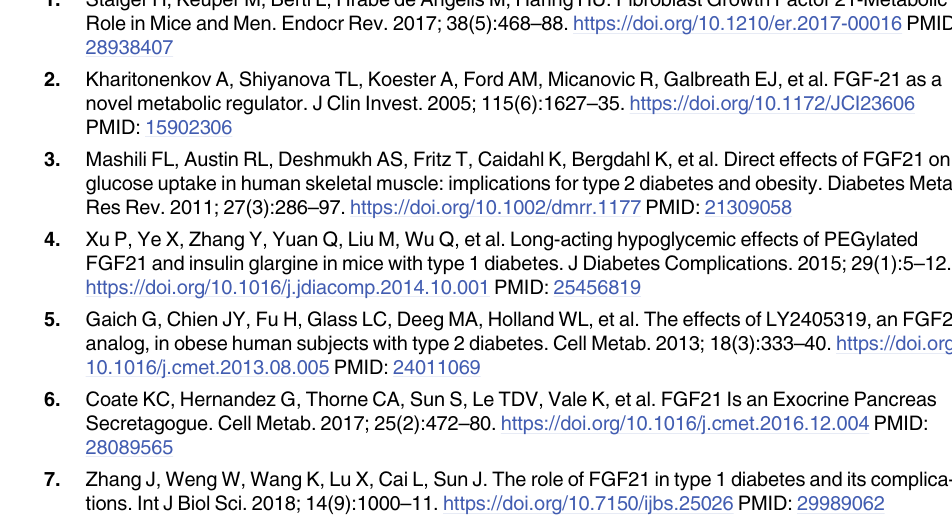
S2 Table. Minimal data